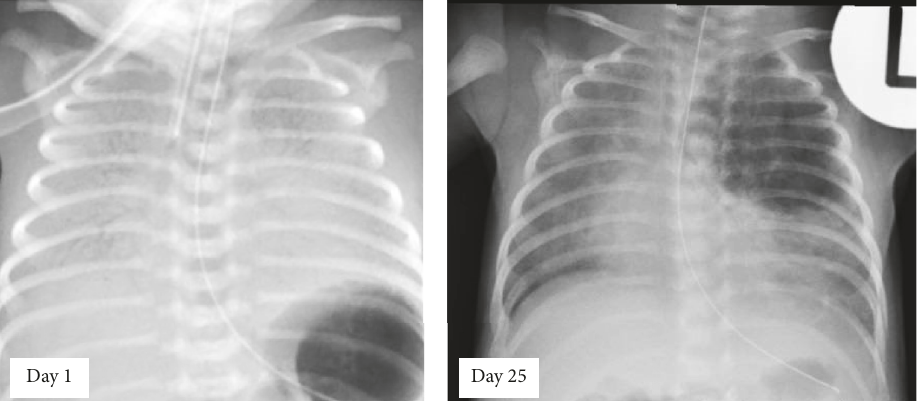
Figure 1: Chest radiographs of neonate showing features of hyaline membrane disease on day 1 of life and typical features of left upper lobe congenital lobar emphysema (CLE) on day 25 of